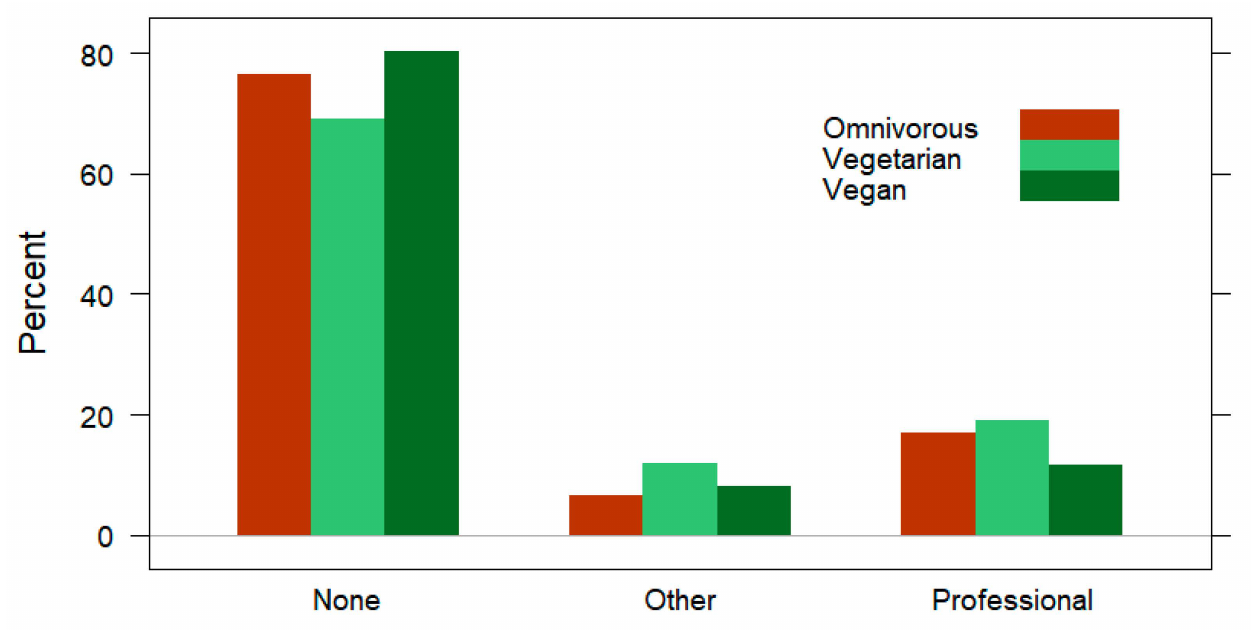
Figure 3. Training advice prevalence (displayed by three clusters) of omnivorous, vegetarian, and vegan runners. Data are presented as the